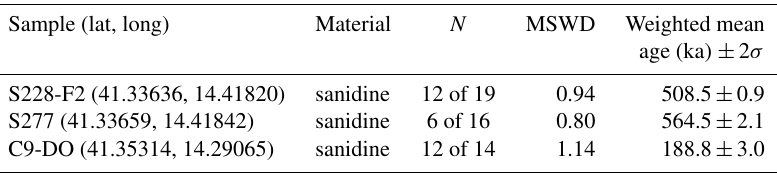
Table 1. Summary of 40 Ar / 39 Ar